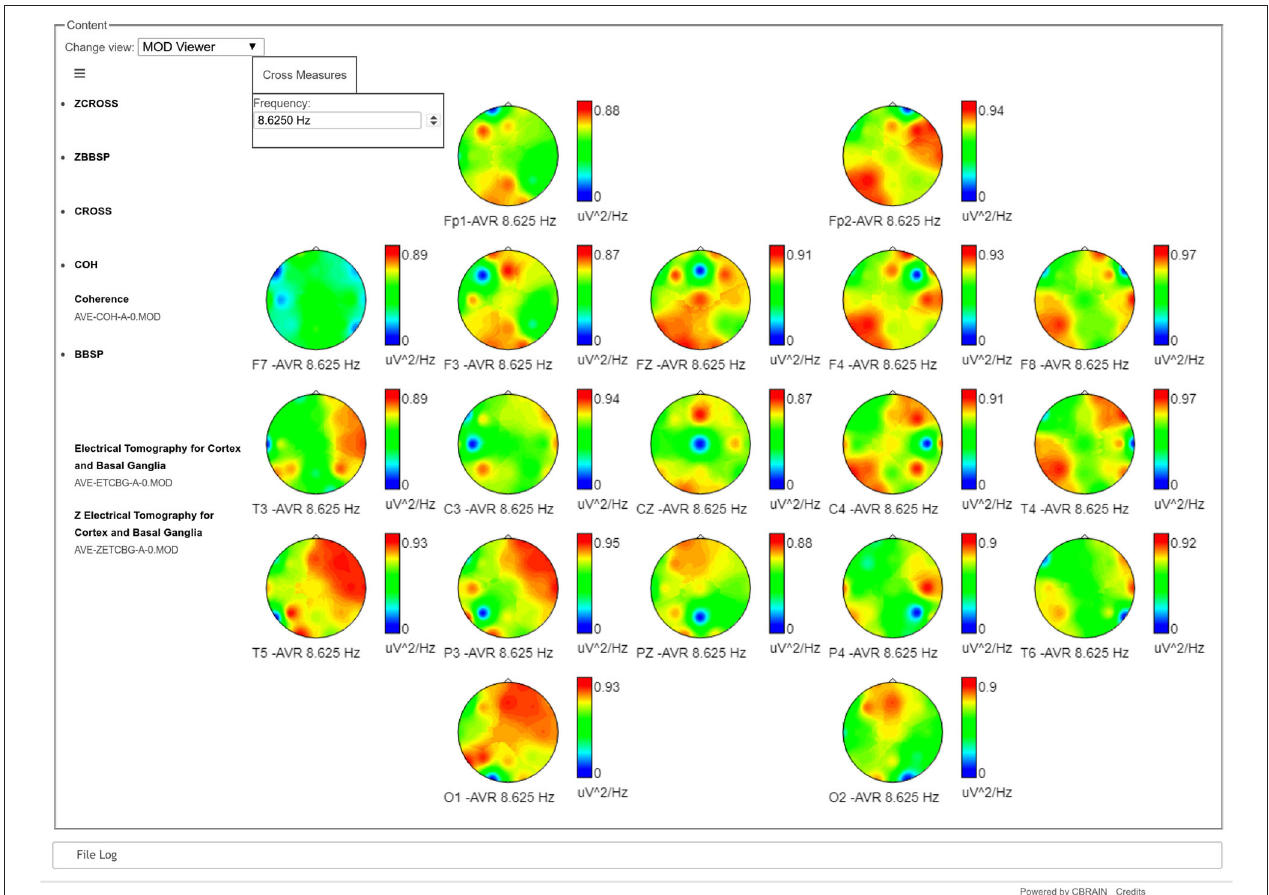
FIGURE 3 | Topographical maps of the coherences of one electrode against the rest, at a specific frequency (8.6Hz in the example). In each map, the blue dot refers to the position of the target electrode, showing its coherence regarding the rest of the head. Values in these maps go from 0 (blue) to red (1). For example, the maps of T5, P3, and O1 show a very high coherence between the parieto-occipital leads of the left hemisphere with the frontal and temporal leads of the contrary hemisphere. In the case of Fp2, it has high coherence values both with the frontal and temporal leads of its same hemisphere and the parietal and occipital leads of the contrary